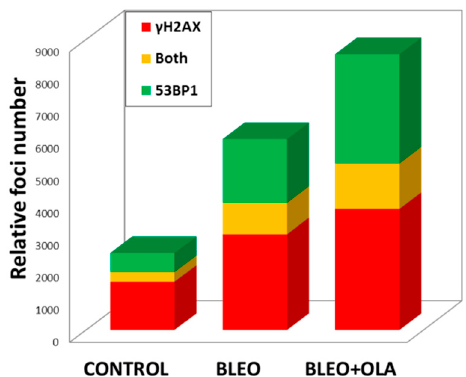
Figure A5. γ H2AX vs. 53 BP1 foci distribution in one experiment. Foci counting required the